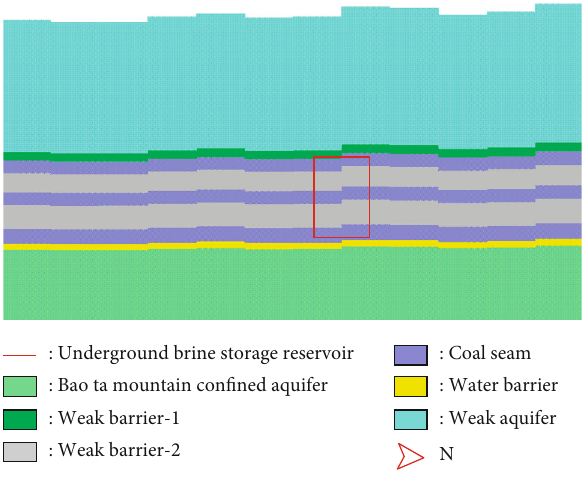
Figure 4: Vertical schematic diagram of underground concentrated brine storage reservoir (the model is stretched 20 times the actual vertical direction) (the model is stretched 20 times the actual vertical direction). Table 3: Geographical location of observation